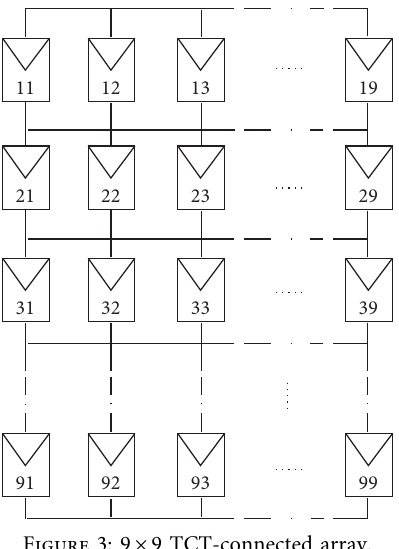
Figure 3: 9 × 9 TCT-connected array.